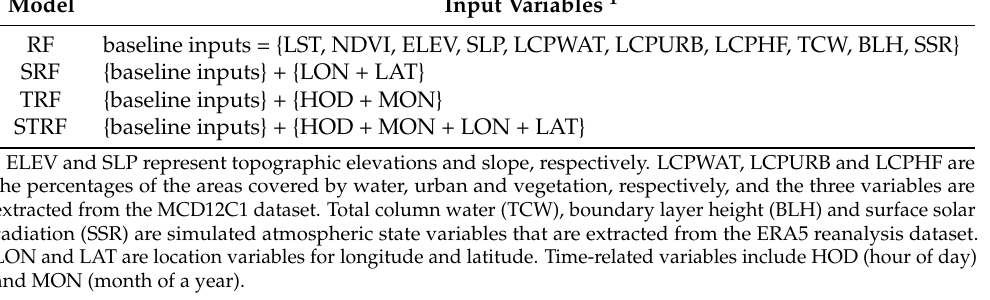
Table 2. Input variables specified for the four hourly SAT estimation models.